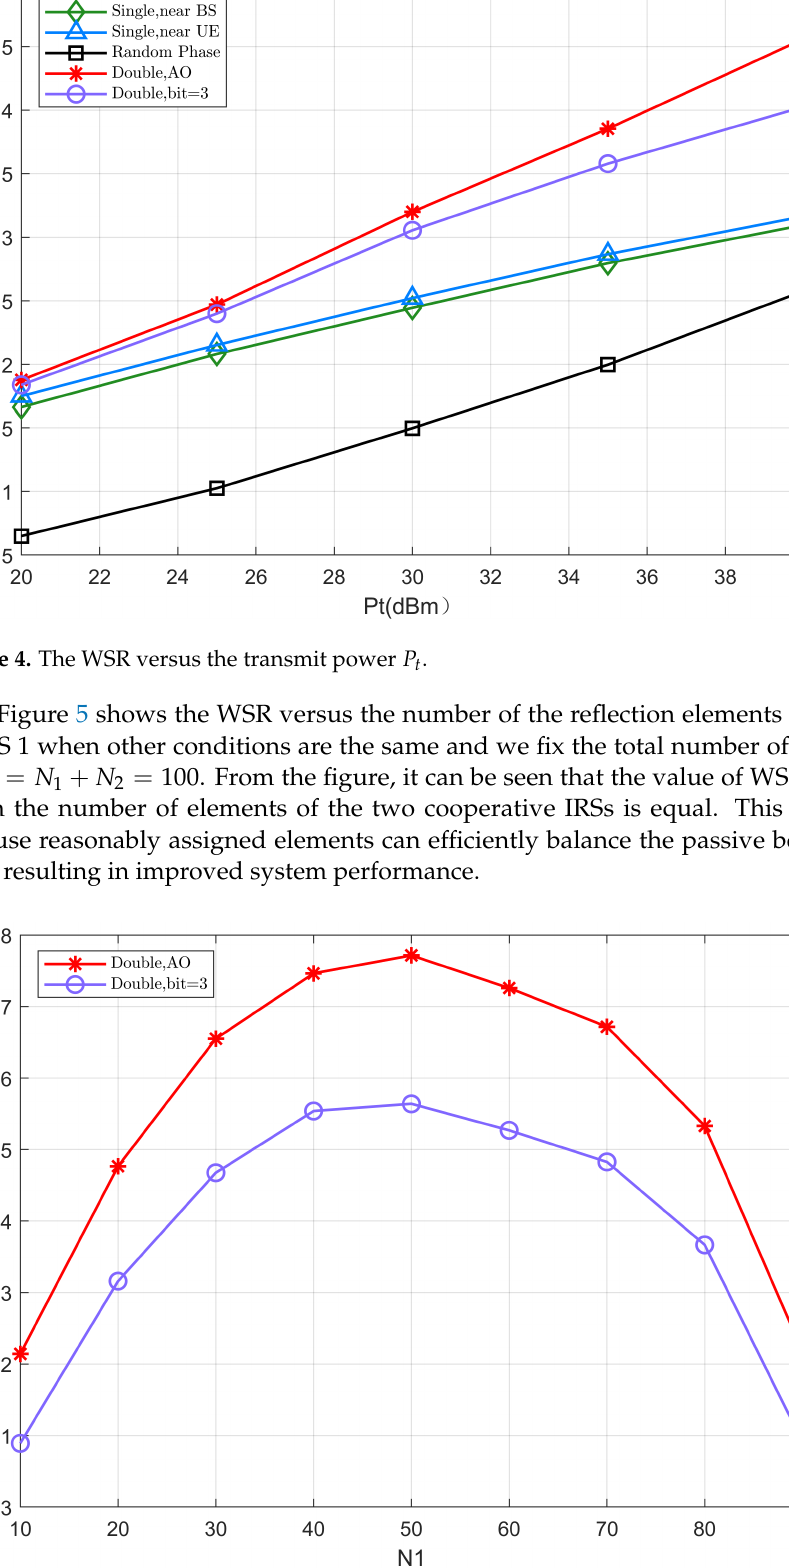
1 assigned to IRS